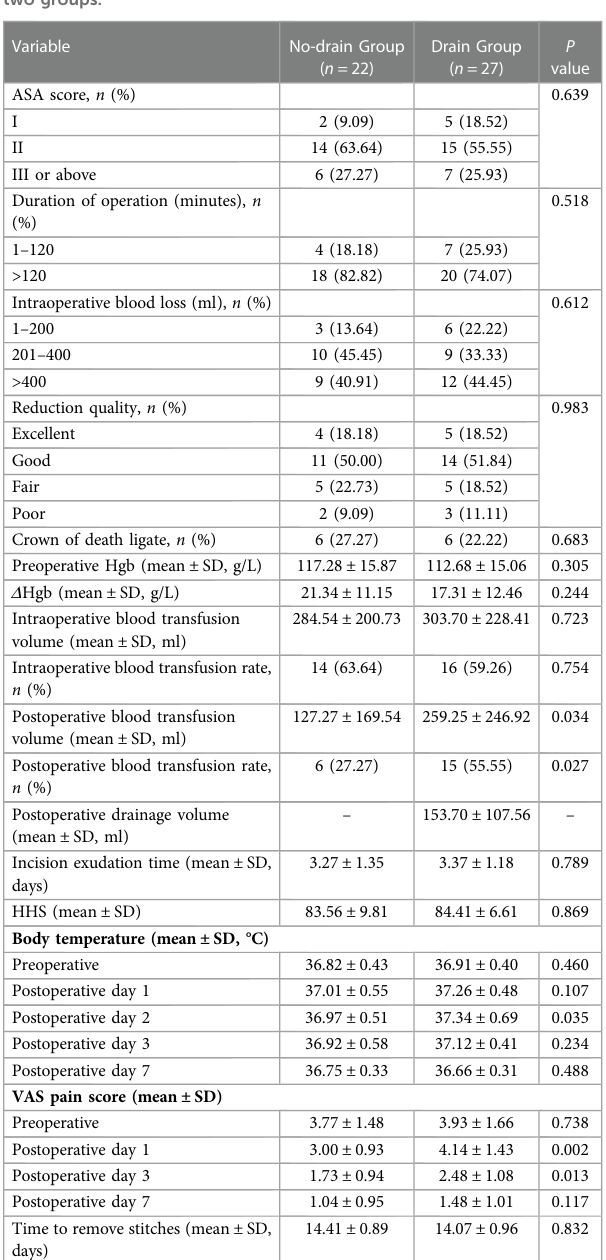
TABLE 2 Comparison of perioperative-related indicators between the two